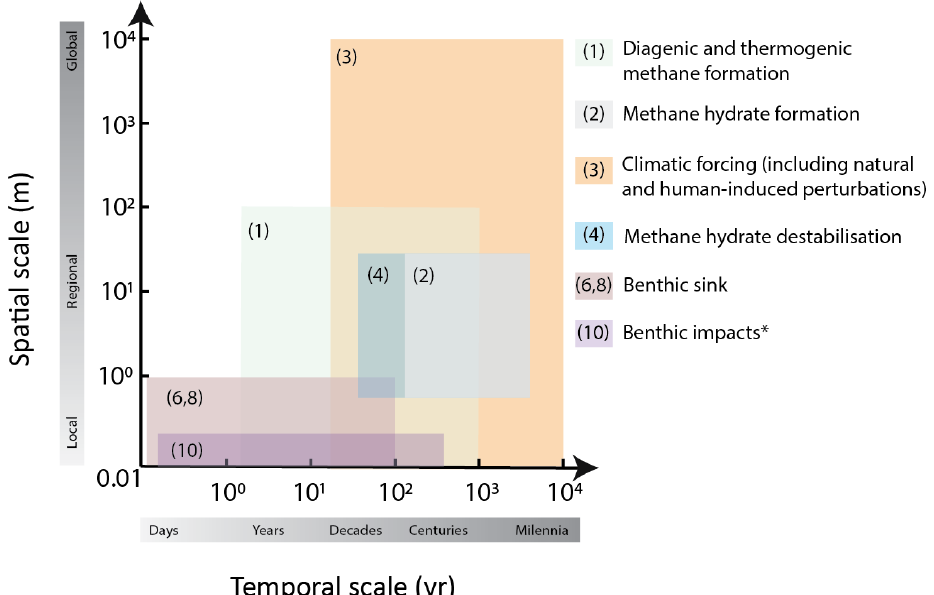
Figure 10. Illustration of the processes that contribute to methane formation/consumption within the sediment column with respect to their temporal and spatial scales. Numbers can be related to those in Figure 9. Note that temporal scales are better constrained than spatial ones due to the wide spatial distribution at which the illustrated processes can take place. In addition, note that hydrate phase change scales are specific for the context of climate forcing. ( ∗ ) Benthic processes with long time scales impacts (>1–10 years) could refer, for example, to the precipitation of thick crusts of authigenic carbonate (>10–20 cm) or significant pH decrease in pore-water via